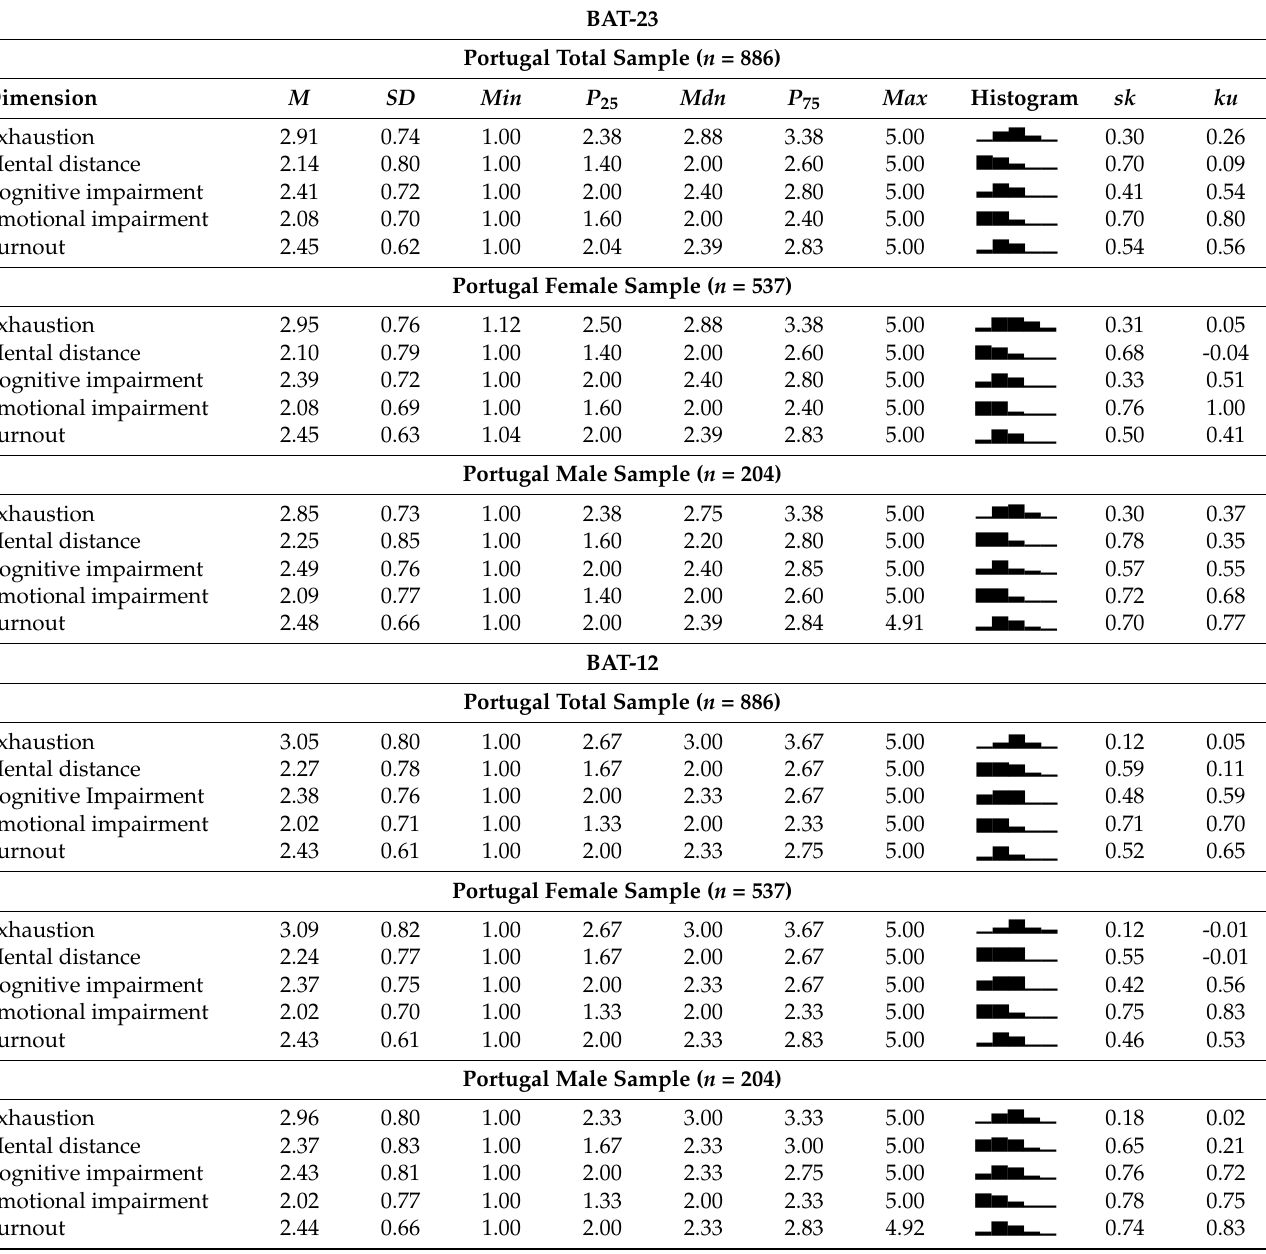
Table 7. BAT’s raw mean scores distributional properties (workers from Portugal). BAT ‐ 23